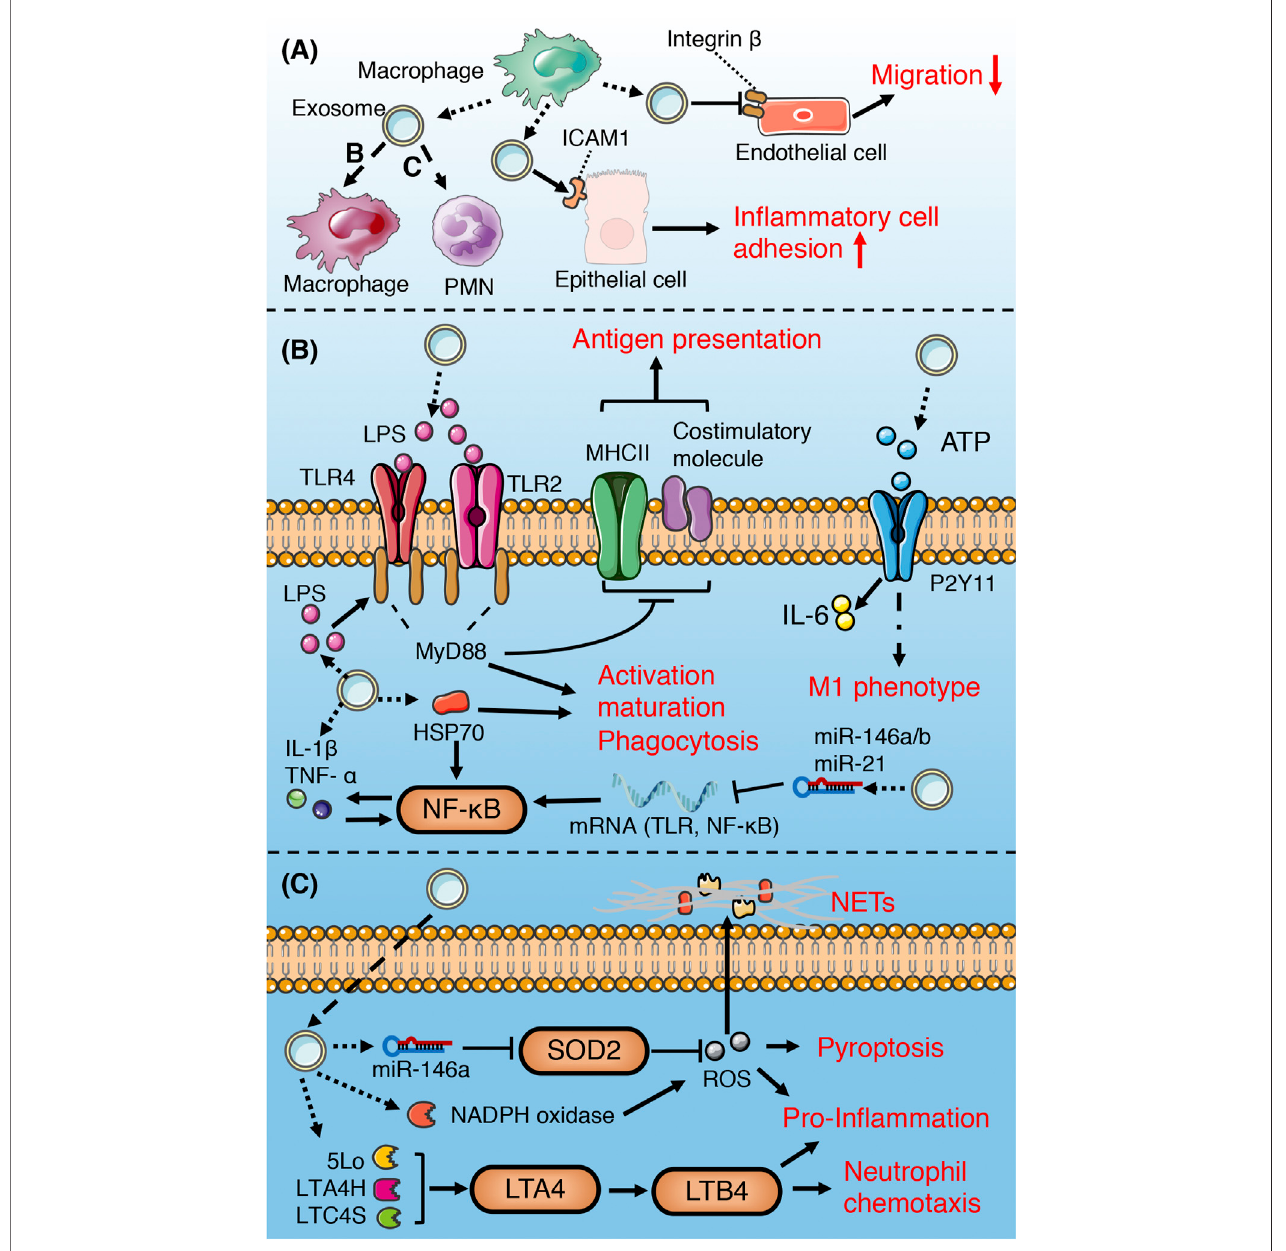
FIGURE6| Role ofmacrophage-derivedexosomesinsepsis (A) macrophage-derivedexosomescaninducepro-in fl ammatory response inrecipientmacrophage and PMN, promote in fl ammatory cell adhesion to endothelium, and suppress migration of epithelial cells (B) macrophage-derived exosomes containing DAMPs and PAMPs promote recipient macrophage activation, maturation, phagocytosis, and M1 polarization, while suppress the ability of antigen presentation. (C) Exosomal enzymes and miRNA increase NETs formation, chemotaxis, pro-in fl ammatory response, and pyroptosis of PMN.